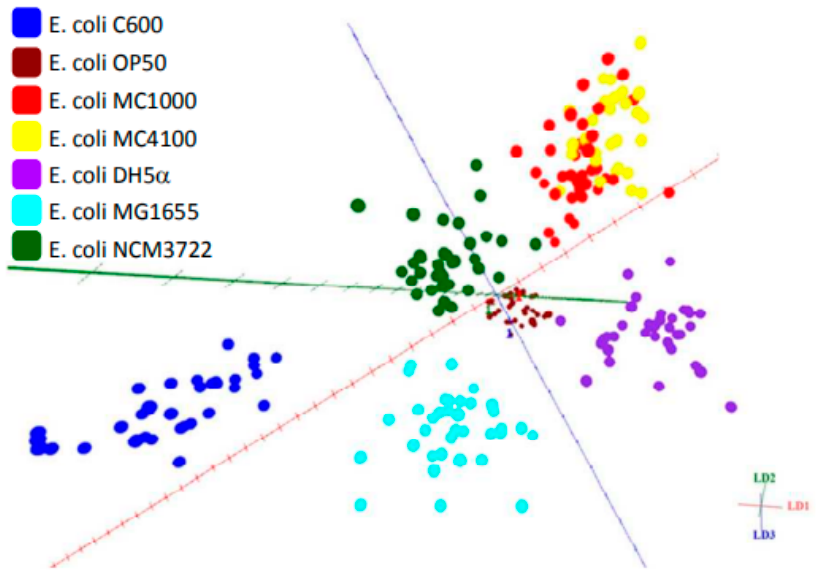
Figure 3. Principal component analysis (PCA)-linear discriminant analysis (LDA) plot differentiating seven strains of E. coli using REIMS, reproduced from [102].